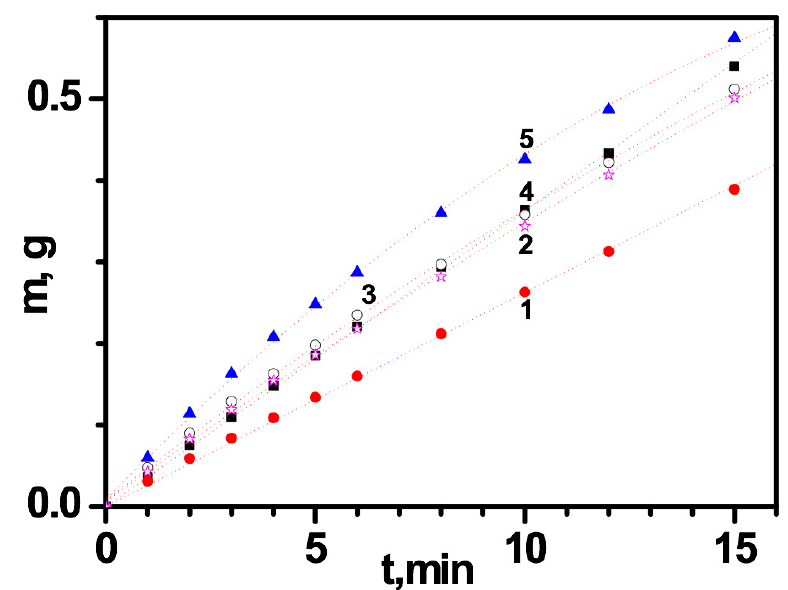
Figure 6. The weight loss of sample as function of time during free evaporation from the Petri dish with a diameter d = 9 cm for the system: ( 1 ) CDE:ethanol, mass ratio 3:1, ( 2 ) ethanol–pure, ( 3 ) FA: ethanol, mass ratio 3:1, ( 4 ) PC: ethanol, mass ratio 3:1, ( 5 ) EP:ethanol, mass ratio 3:1. Temperature T = 22 °C, relative humidity H = 25%.